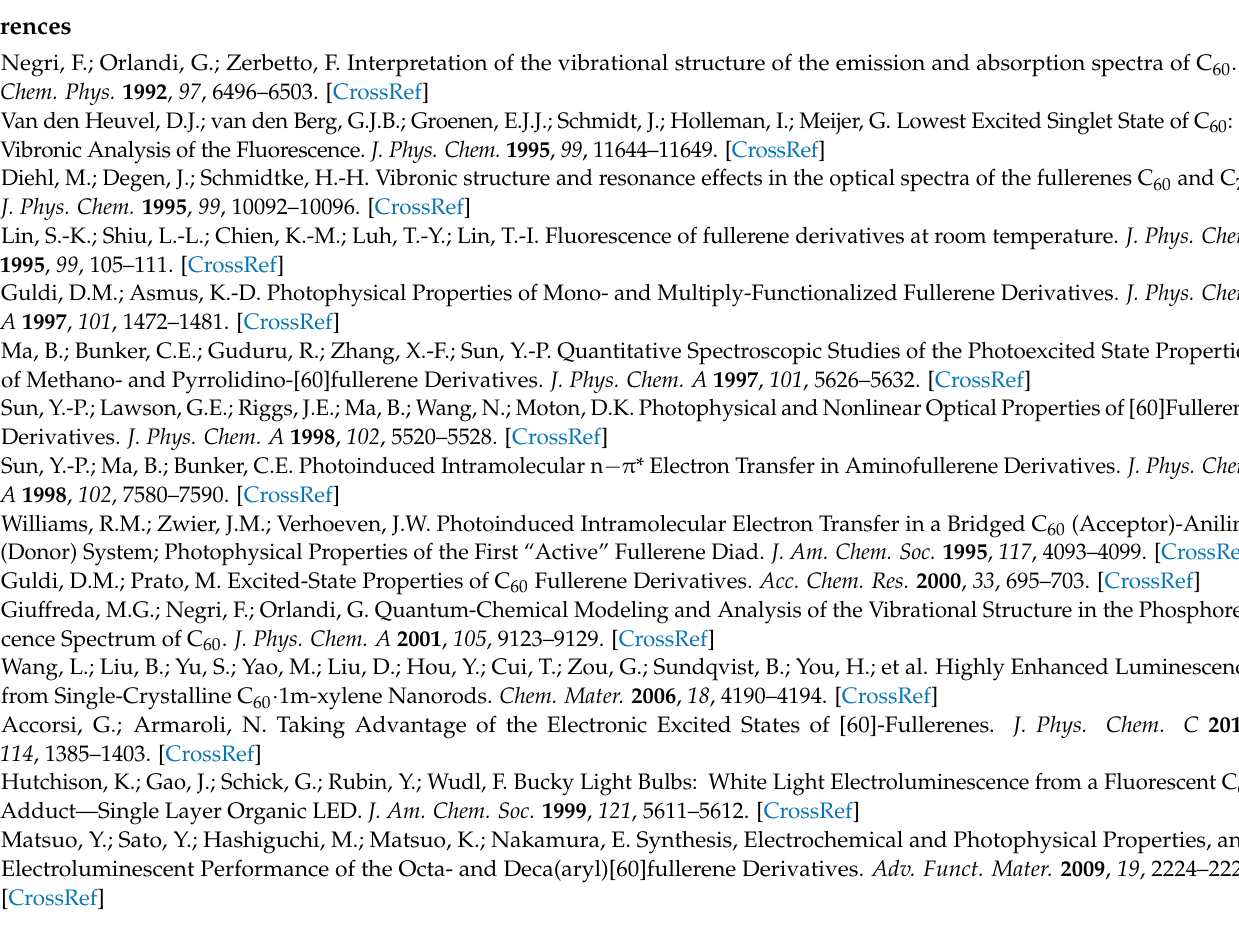
Figure S4: COSY spectra of C 70 (OCH 3 ) 10 [C(COOEt) 2 ]; Figure S5: HSQC of C 70 (OCH 3 ) 10 [C(COOEt) 2 ]; Figure S6: 1 H NMR spectrum (500 MHz, CDCl 3 ) of C 70 (OCH 3 ) 10 [C(COOEt) 2 ] 2 ; Figure S7: 13 C NMR spectrum (500 MHz, CDCl 3 ) of C 70 (OCH 3 ) 10 [C(COOEt) 2 ] 2 ; Figure S8: ESI-FT-ICR-HRMS spectra of C 70 (OCH 3 ) 10 [C(COOEt) 2 ] 2 ; Figure S9: COSY spectra of C 70 (OCH 3 ) 10 [C(COOEt) 2 ] 2 ; Figure S10: HSQC spectra of C 70 (OCH 3 ) 10 [C(COOEt) 2 ] 2 ; Table S1: Crystallographic data for C 70 (OCH 3 ) 10 [C(COOEt) 2 ]; Figure S11: Natural Population Analysis (NPA) charge distribution of C 70 (OCH 3 ) 10 (A), C 70 (OCH 3 ) 10 [C(COOEt) 2 ]-I (B), C 70 (OCH 3 ) 10 [C(COOEt) 2 ]-II (C), C 70 (OCH 3 ) 10 [C(COOEt) 2 ]-III (D). And C 70 (OCH 3 ) 10 is shown in three orientations front view, top view and bottom view (E); Figure S12: Electrostatic potentials on the 0.001 a.u. molecular sur- faces of C 70 (OCH 3 ) 10 (A), C 70 (OCH 3 ) 10 [C(COOEt) 2 ] (B) and C 70 (OCH 3 ) 10 [C(COOEt) 2 ] 2 (C), cal- culated at B3LYP-D3BJ/6-31G(d, p) level with toluene solvent; Figure S13: Molecular orbitals (HOMO-1, HOMO, LUMO, and LUMO+1) of C 70 (OCH 3 ) 10 (A), C 70 (OCH 3 ) 10 [C(COOEt) 2 ] (B) and C 70 (OCH 3 ) 10 [C(COOEt) 2 ] 2 (C) calculated at B3LYP-D3BJ/6-31G(d, p) level, in toluene; Figure S14: The most favorable structure of C 70 (OCH 3 ) 10 [C(COOEt) 2 ] 2 . References [31–40] are cited in supplementary